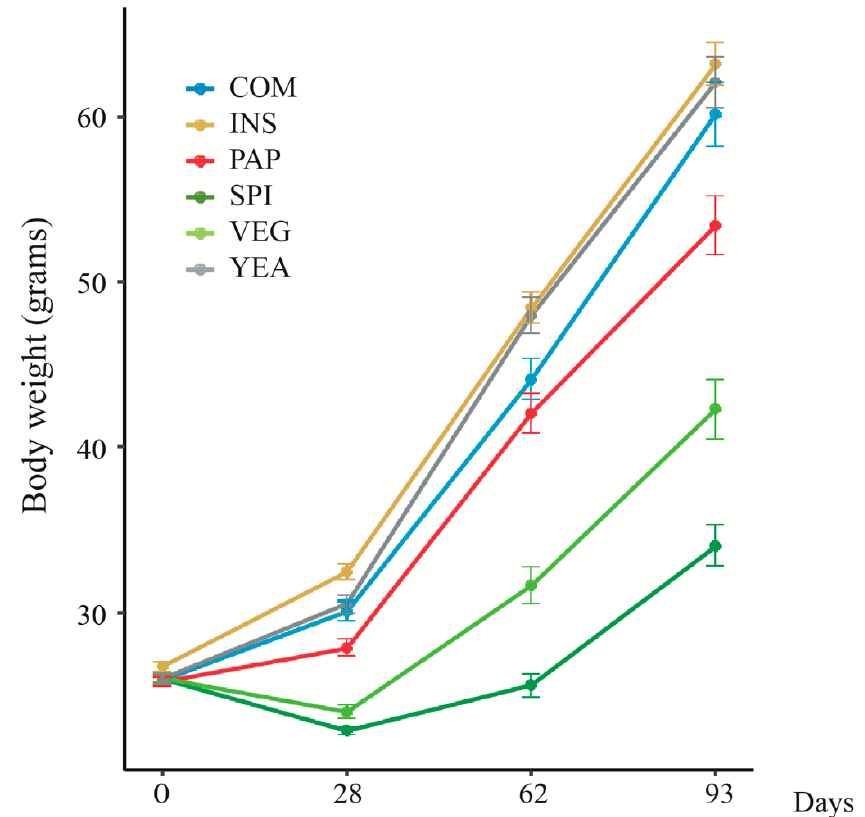
Figure 2. Evolution of tagged fish body weight gain according to used experimental diets. See Figure 1 for diet description. Body weights for each diet are presented as mean ± standard error ( n = 159 for each diet except for COM with n = 53.).